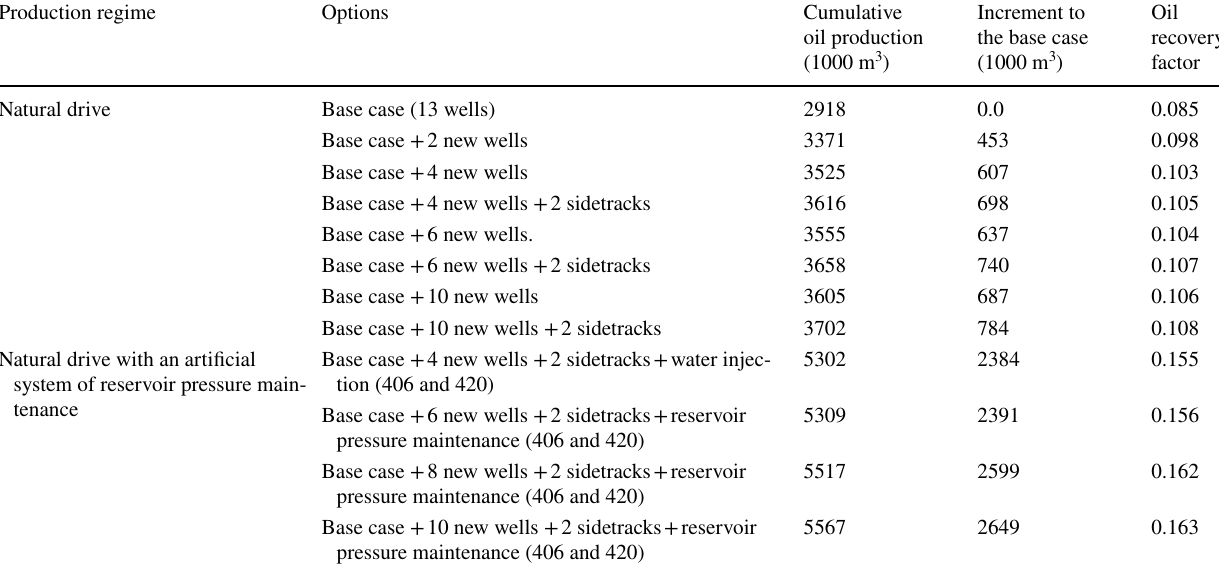
Table 5 Comparison of the oil recovery factor depending on the well stock and production regime Production